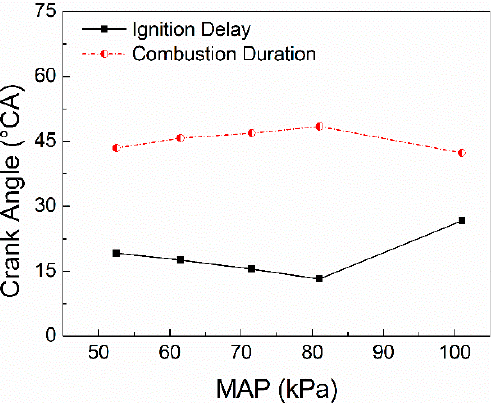
Figure 8. Ignition delay and combustion duration under the various MAPs.